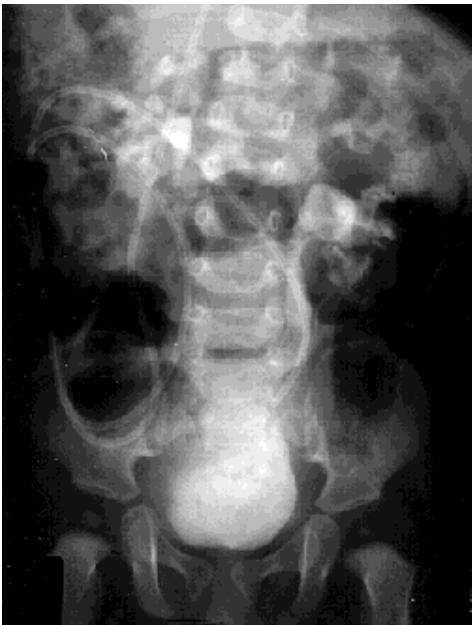
FIGURE 1b . IVP showing a left duplex system with the staghorn calculus in the lower renal pole moiety and a single right system with a partial staghorn calculus of the lower renal